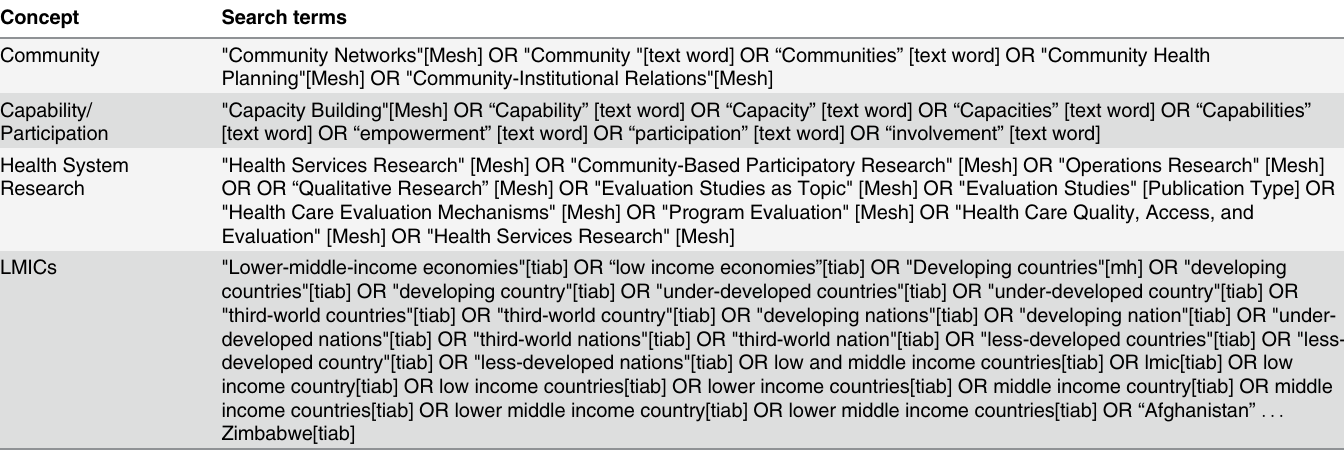
Table 1. Concepts and associated terms used in literature